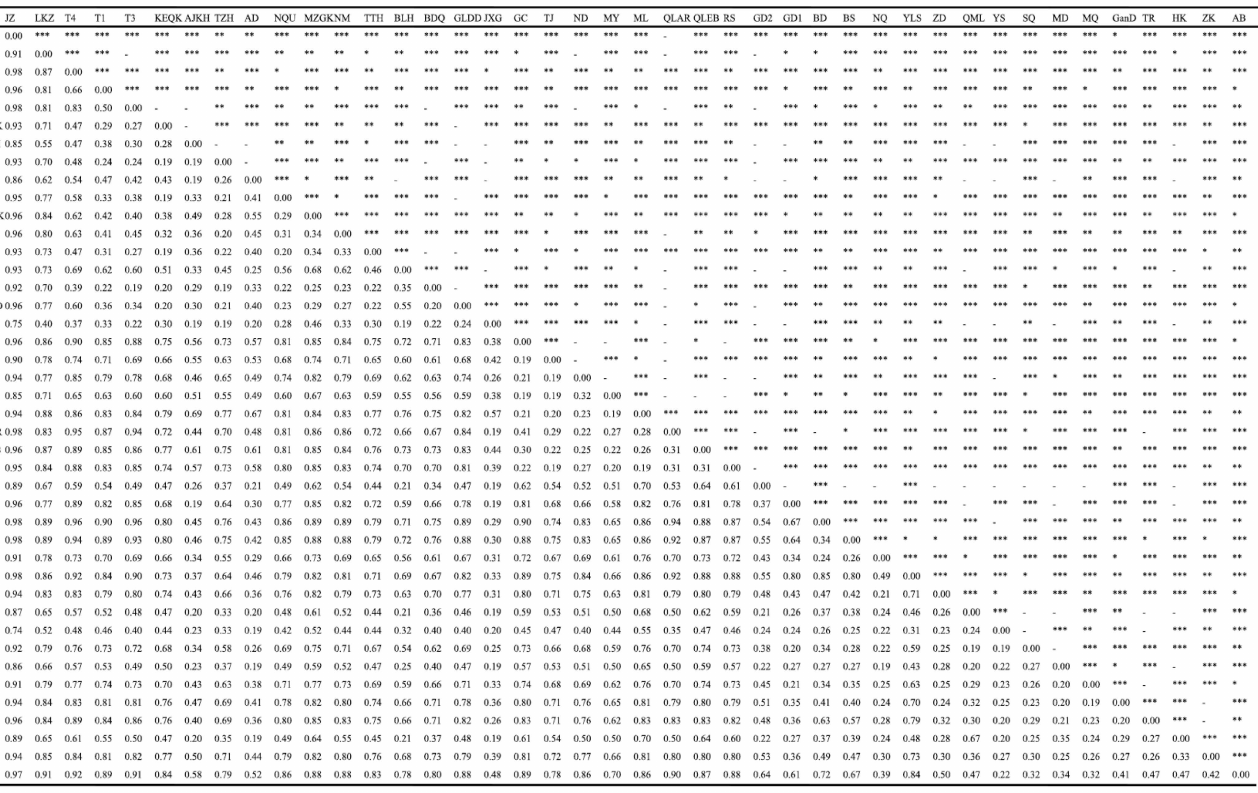
Figure A1. The fixation index ( F ST ) results for 42 populations. The diagonal indicates the level